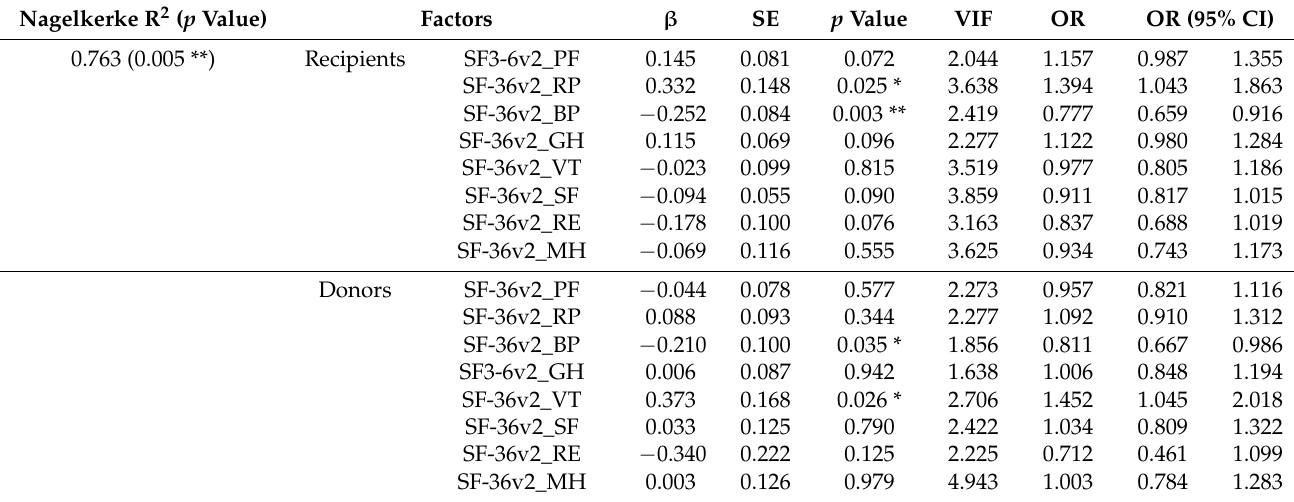
Table 3. Significant impact factors of SF-36v2 on choosing between PEKT and PDKT. * p < 0.05, ** p < 0.01 based on binomial logistic regulation analysis with robust standard errors. Multicollinearity was suspected if the VIF value was greater than 10. * p < 0.05, ** p < 0.01: significant impact factor on choosing PEKT or PDKT for recipients and donors.